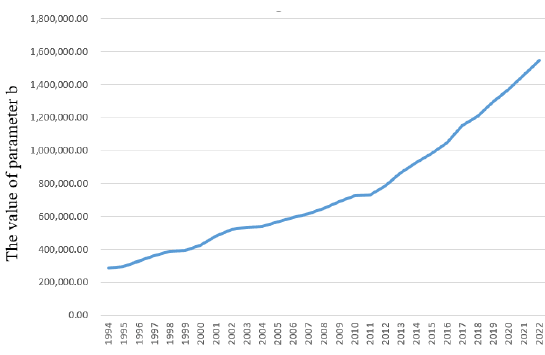
Figure 7. The value of parameter ‘ b ’.